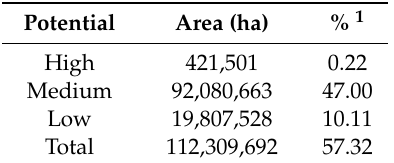
Table 14. Available areas for JCL cultivation in Mexico, scenario